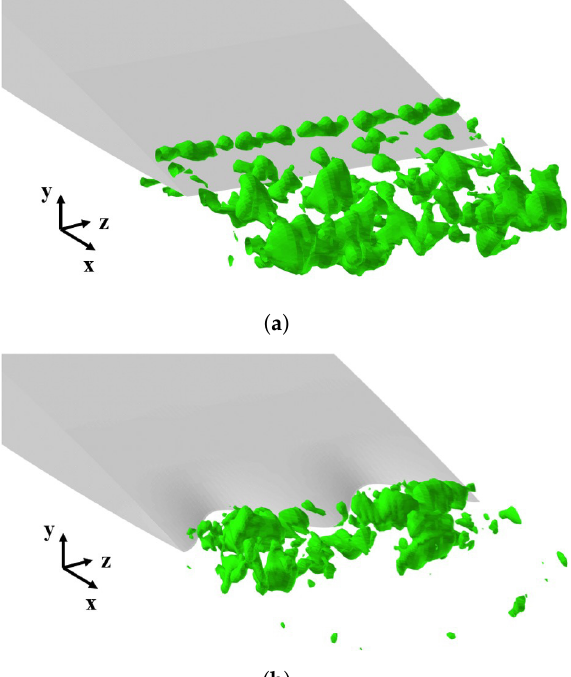
Figure 9. Iso-contours of Reynolds stress R 22 = 0.05 near the trailing edge: ( a ) NACA0012 airfoil; and ( b ) serrated